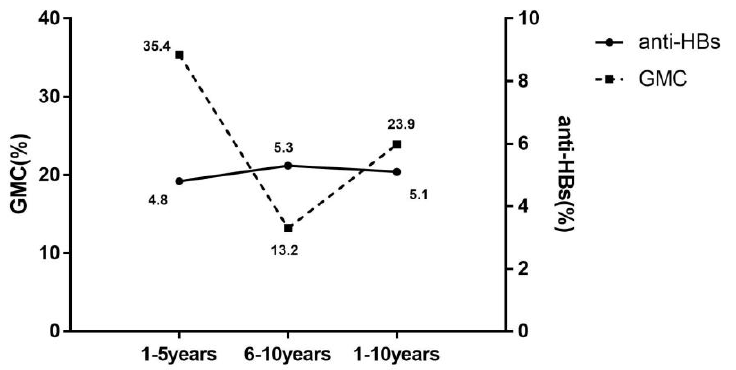
Figure 2. Mean annual decrease rate of seroprotection rate and GMC with the duration of immun ‐ ization. anti ‐ HBs(%), the mean annual decrease rate of antibody against hepatitis B virus surface antigen (mean annual decrease rate of seroprotection rate); GMC(%), the mean annual decrease rate of geometric mean concentration of anti ‐ HBs; 1–5 years, 1–5 years after the full course of vaccination; 6–10 years, 6–10 years after the full course of vaccination; 1–10 years, 1–10 years after the full course of vaccination.